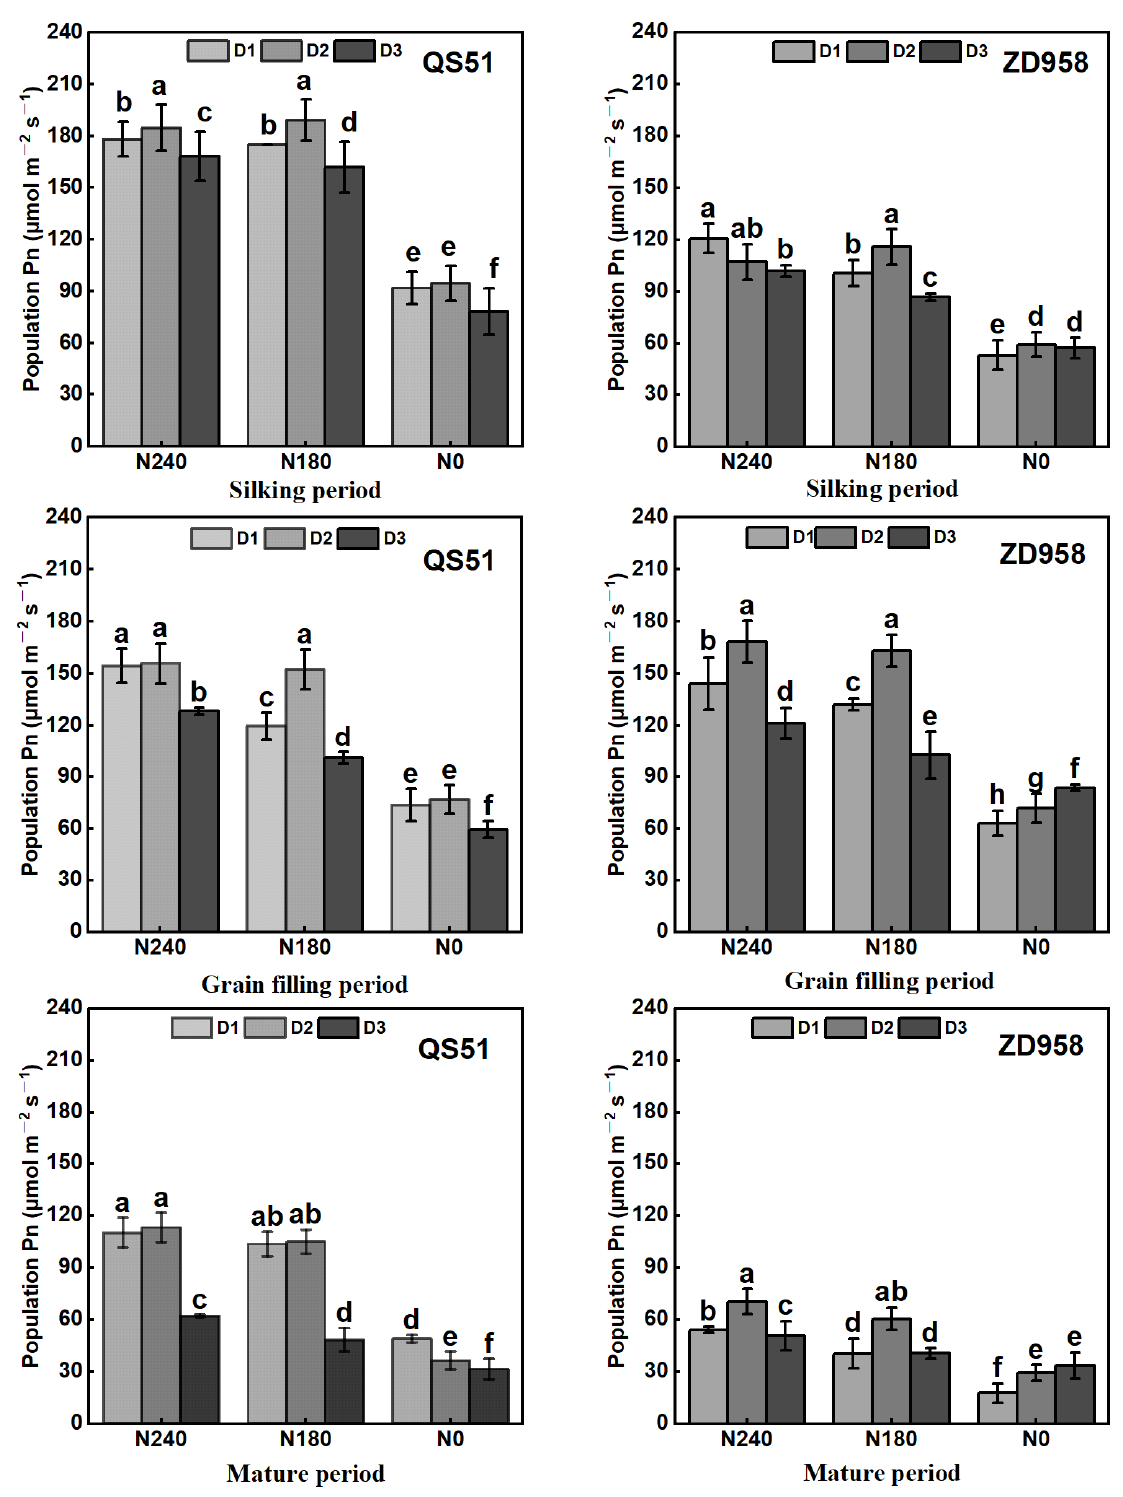
Figure 4. Effects of planting density and nitrogen (N) rate on population photosynthetic rate ( P n ) of maize at different growth stages. D1: 80,000 plants ha − 1 ; D2: 100,000 plants ha − 1 ; D3: 120,000 plants ha − 1 ; N0: no N application; N180: 180 kg N ha − 1 ; N240: 240 kg N ha − 1 . Bars are the means ± standard deviation (n = 3). Different lower-case letters denote significant differences at p < 0.05 among treatments at the same growth stage.